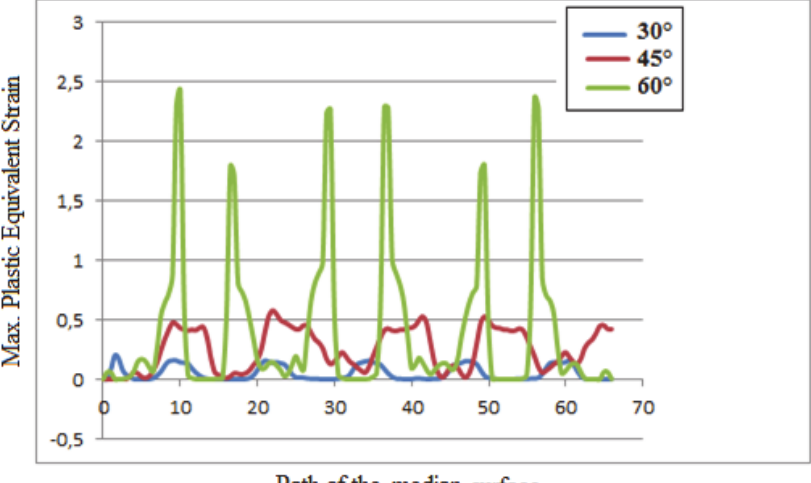
Figure 14: Evolution of the equivalent plastic strain for a trajectory in the median of the sample using different angles of